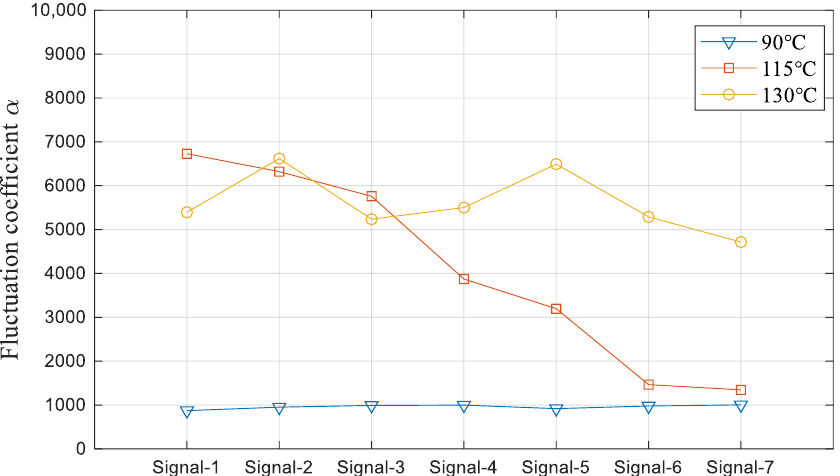
Figure 11. Fluctuation coefficients of the signals with a heating temperature of 90, 115, and 130 °C.